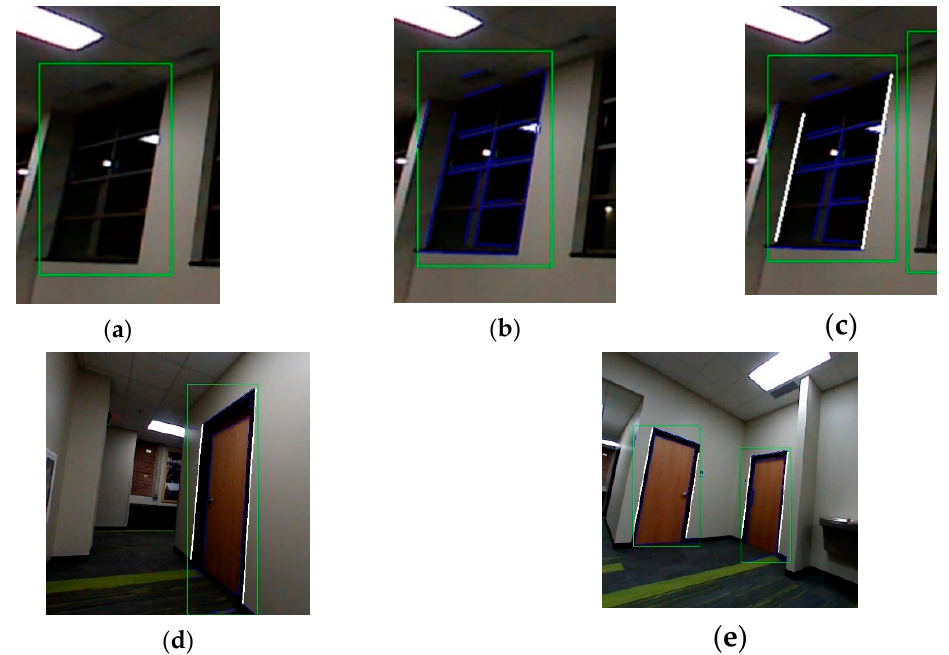
Figure 2. Macro-feature detection and refinement process from ( a ) YOLOv2 bounding box, ( b ) lines detection using Line Segment Detector (LSD) algorithm, ( c ) vertical sides of the object detected and marked, ( d ) vertical sides of single door detected and marked and ( e ) multiple doors detected and marked.